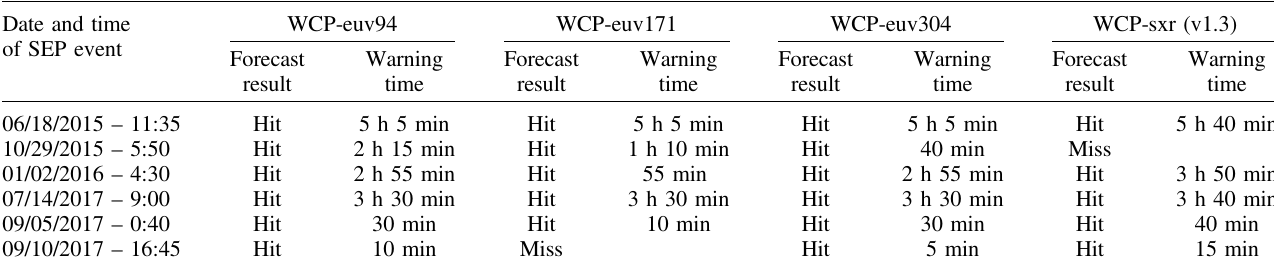
Table 6. Summary of the forecasting results of the WCP-euv94, WCP-euv171, WCP-euv304 and WCP-sxr (v1.3) models using out-of-sample data for predicting the SEP events presented in Table 1 for the period from November 2014 to December 2017.